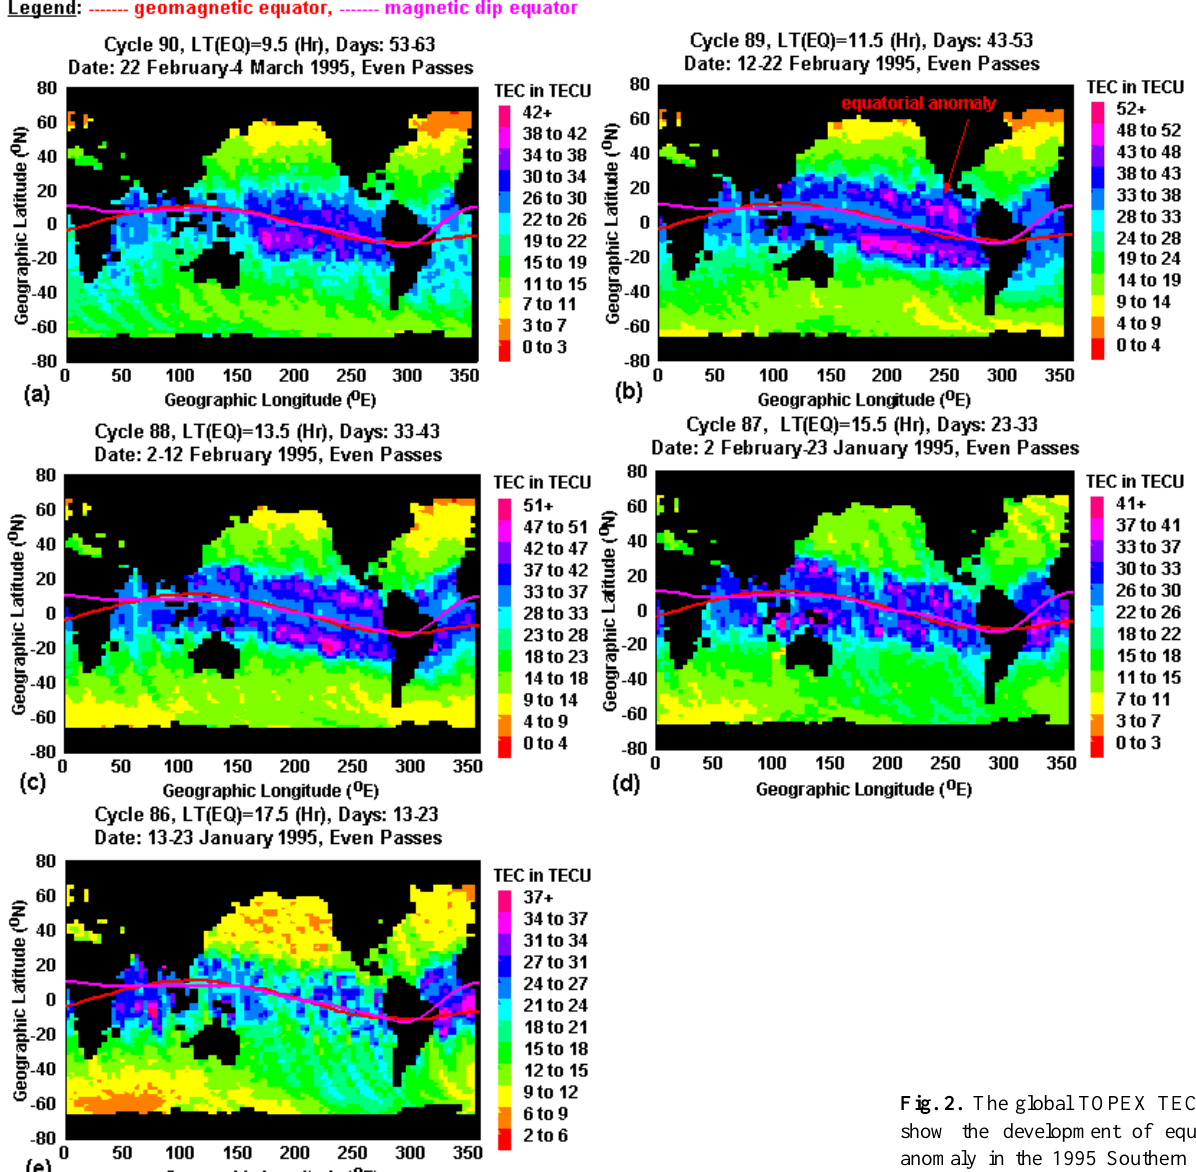
Fig. 2. The global TOPEX TEC maps show the development of equatorial anomaly in the 1995 Southern Hemi- sphere summer and autumnal